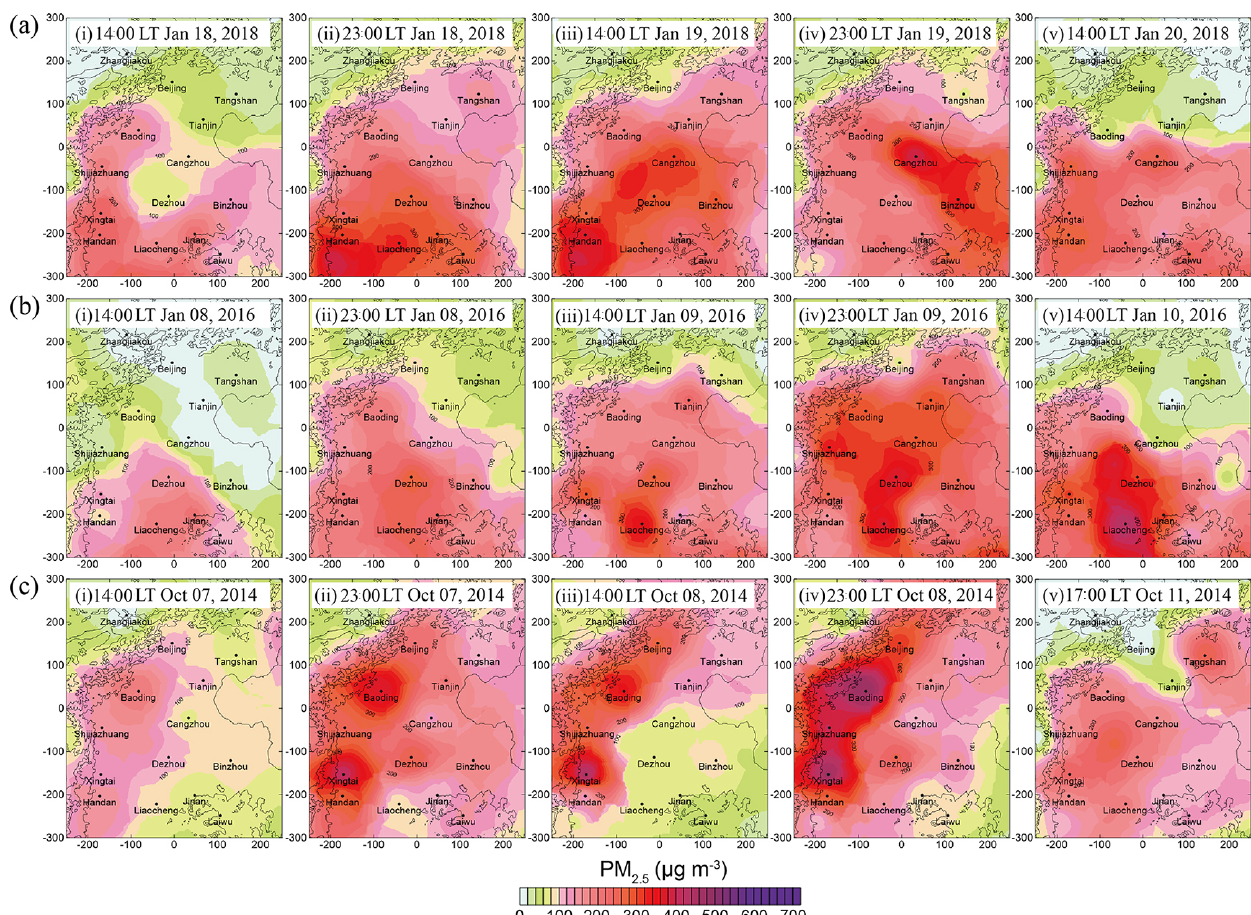
Figure 4. Spatial distributions of observed surface PM 2 . 5 concentrations (shaded colors) at the pollution stages of (i) formation, (ii–iv) main- tenance, and (v) diffusion during representative cases 1–3 under (a) west–southwest wind shear mode, (b) south–north wind shear mode, and (c) topographic obstruction category. Values shown on x and y axes denote the distances (km) to the domain center. The PM 2 . 5 concentration fields are derived from spatial interpolation of pollution-observed data at monitoring